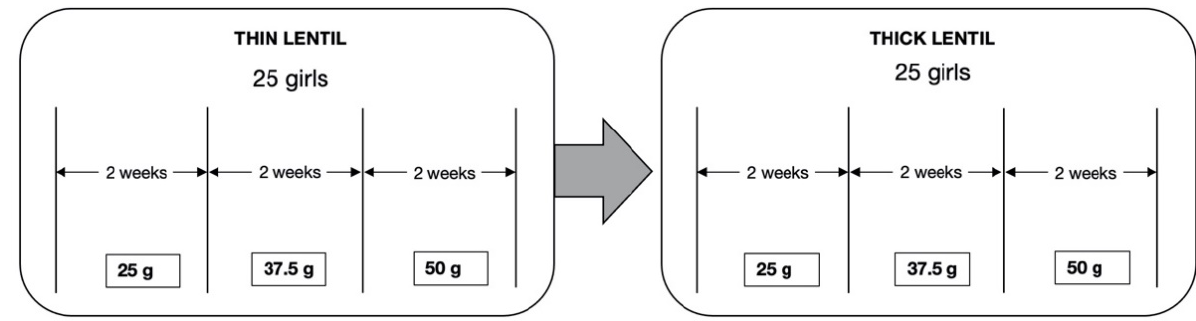
Figure 1. Cross-over design of the study that included 25 adolescent girls in each club (4 clubs × 25 adolescent girls = 100 adolescent girls).